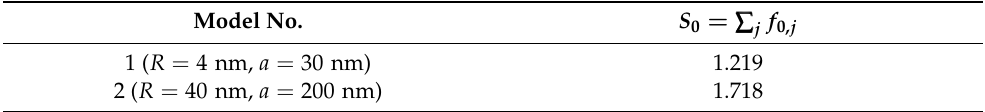
Table 1. Oscillator-strength sum rules for the radiative transitions involving the ground-state, in the case of the two models described in the present